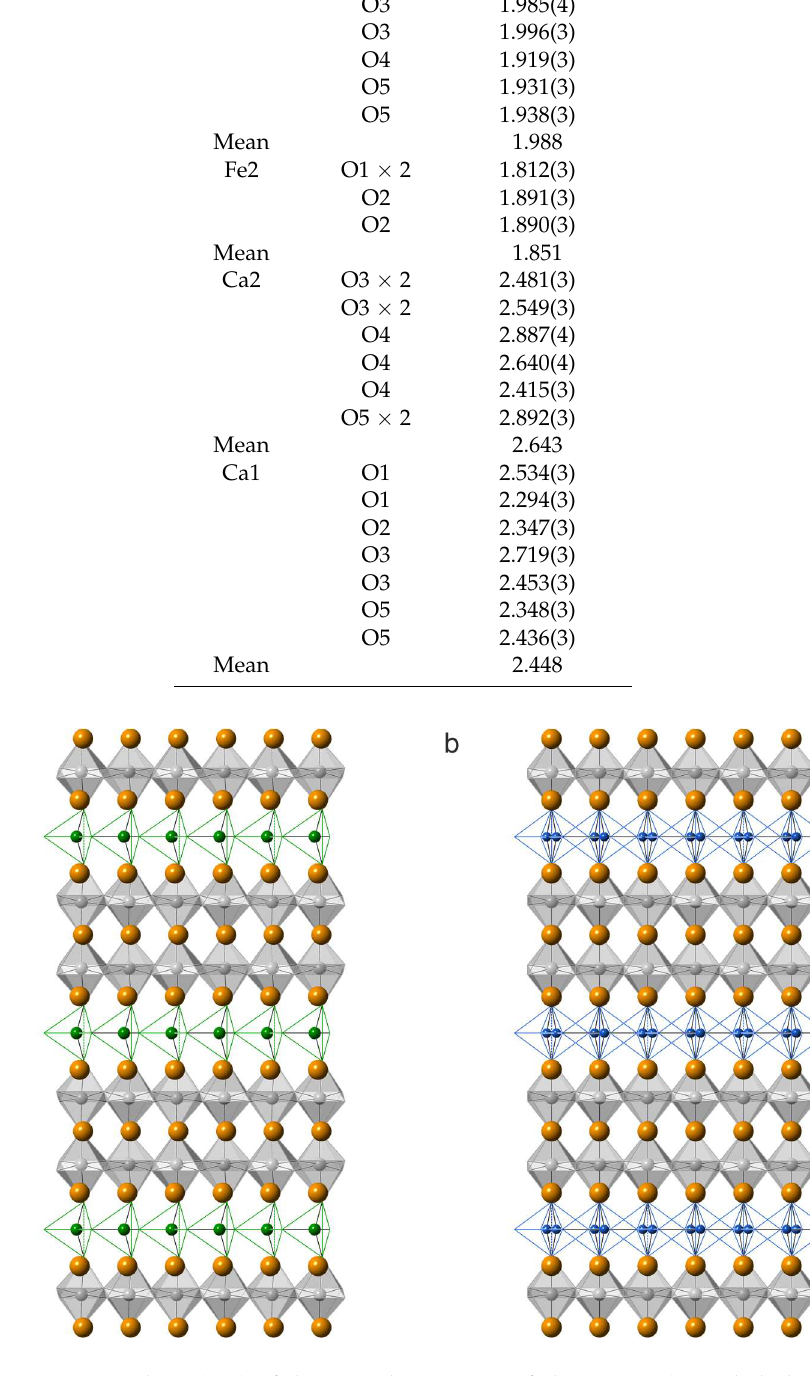
Figure 8. Projections along (001) of the crystal structures of sharyginite ( a ) and shulamitite ( b ). Calcium atoms are shown as orange spheres, 0.5Fe 3+ /0.5TiO 6 octahedra are in grey, green, and blue spheres, and bonds corresponding to the tetrahedra centred mainly by Fe 3+ and Al 3+ ions, respectively. In shulamitite ( b ), the tetrahedral chains are disordered and both possible configurations are show